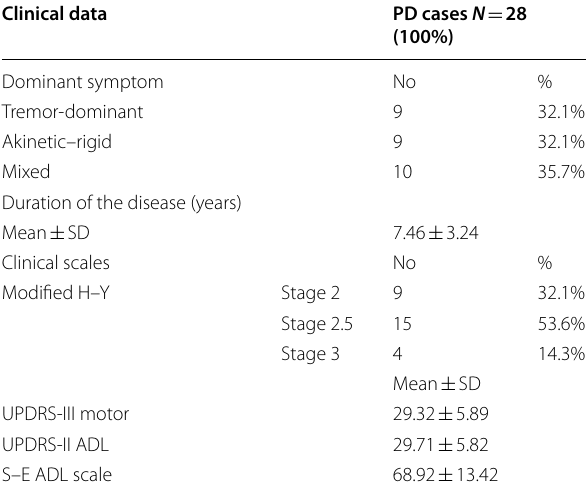
Table 2 Clinical data of PD